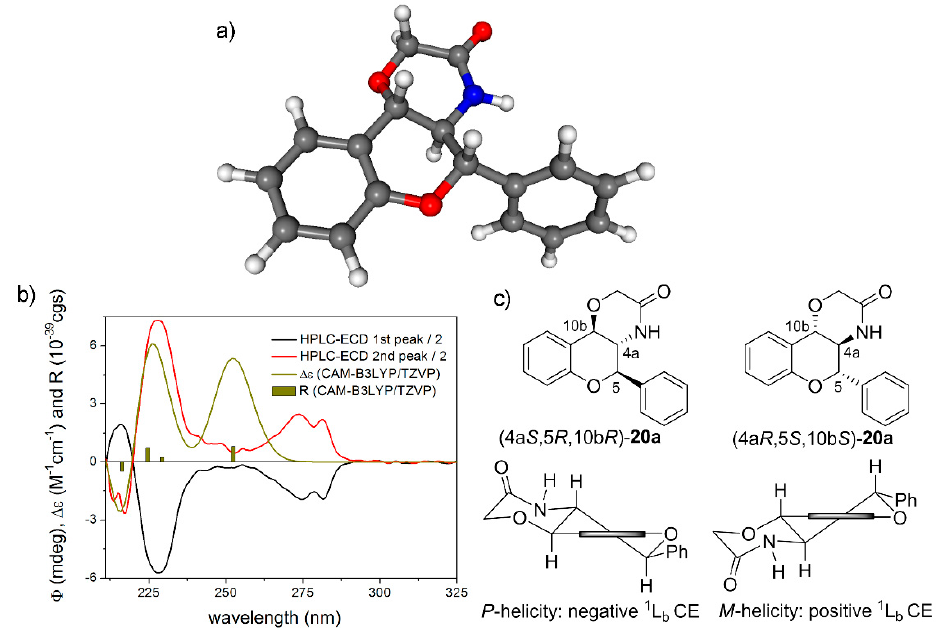
Figure 7. ( a ) Single low-energy CAM-B3LYP / TZVP PCM / CHCl 3 conformer of (4a R ,5 S ,10b S )- 20a containing a flavan chromophore with M -helicity. ( b ) HPLC-ECD spectra of the first (black line) and the second-eluting (red line) enantiomers of 20a compared with the CAM-B3LYP / TZVP PCM / CHCl 3 // CAM-B3LYP / TZVP PCM / CHCl 3 spectrum of (4a R ,5 S ,10b S )- 20a (olive line). The bars represent rotational strength values for the single low-energy solution conformer. ( c ) Structure and helicity of the separated enantiomers of rac- 20a . Horizontal thick line represents the plane of the condensed benzene